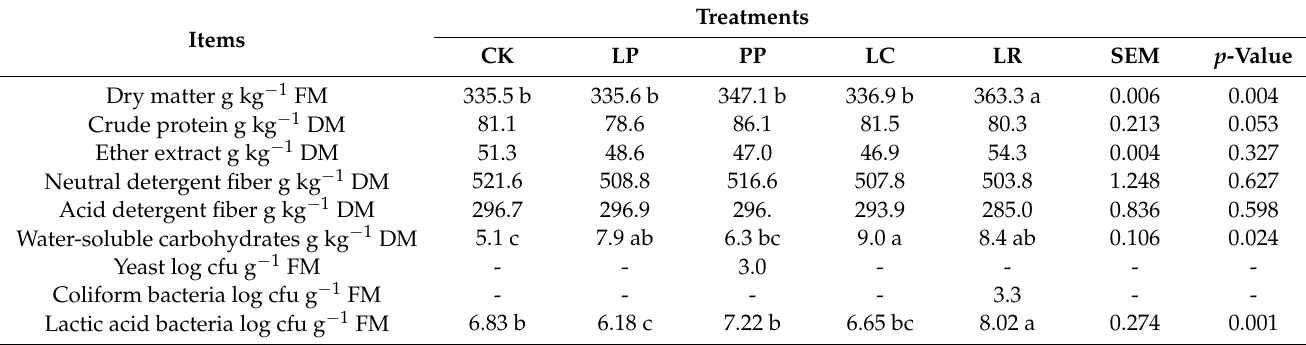
Table 2. Chemical composition and microbial population of the oat silage by plate